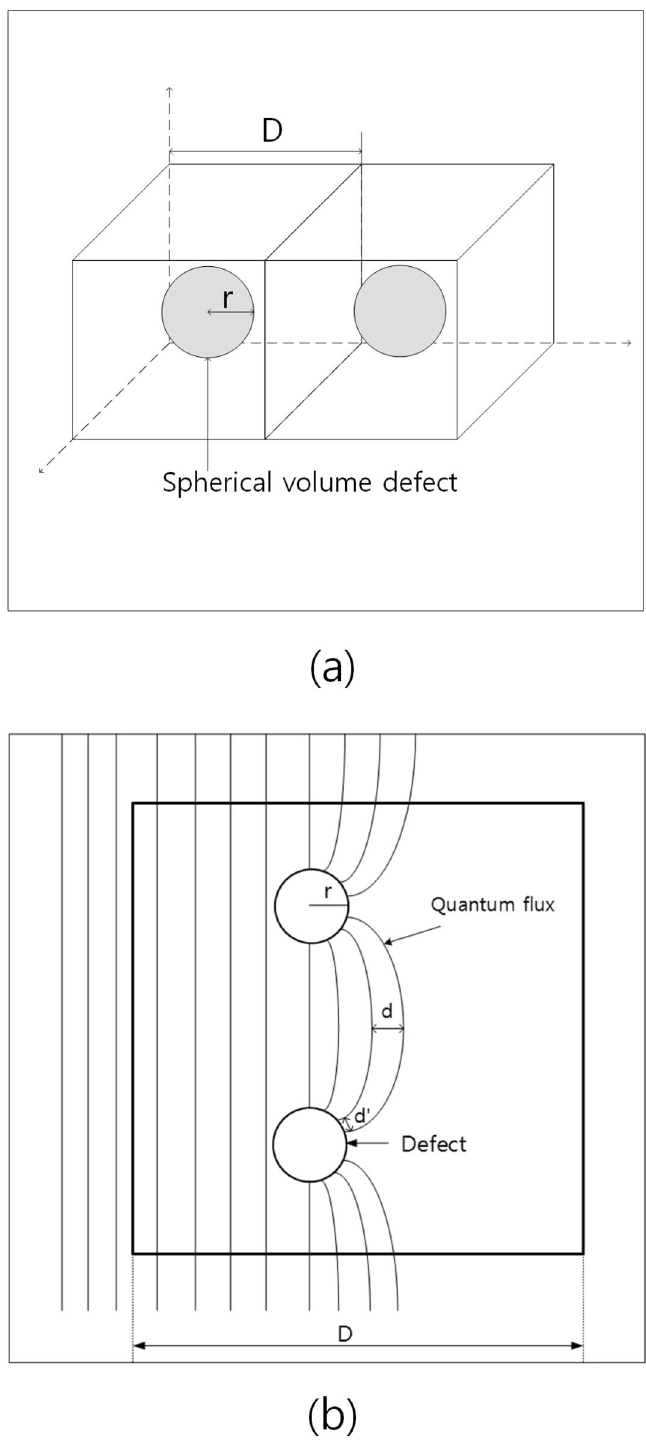
Figure 4. ( a ) Schematic representation of doped volume defects in MgB 2 base. ( b ) Schematic representation of pinned fluxes at volume